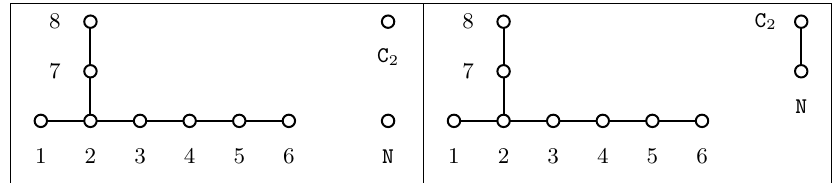
Figure 16. Dynkin diagrams corresponding to the possible ways of adding a node N to the diagram of E 8 + A 1